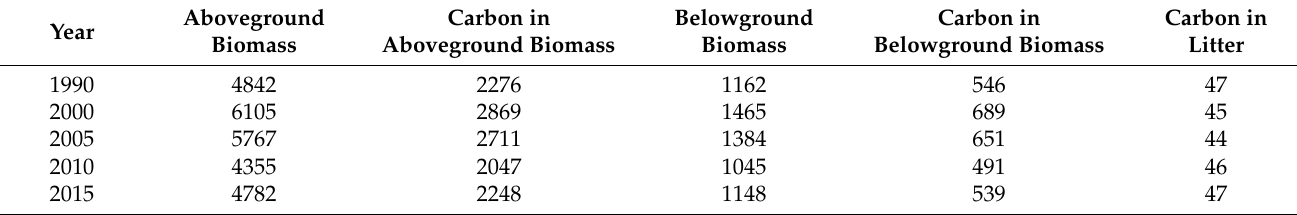
Table 2. Forest biomass and carbon stock (million tons) in Malaysian forests [5].